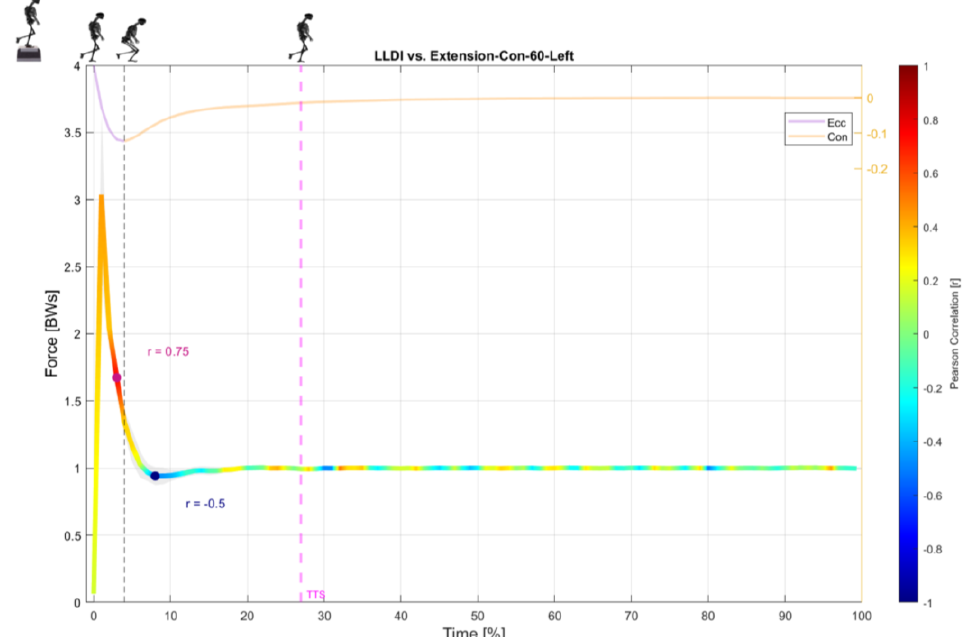
Figure 4. Representative landing force–time trace with SPM regression result for the relationship between landing force (bottom coloured line) and concentric extensor strength. Note: The force–time trace is linked to the primary y-axis, whereas each time node (x-axis) for the force trace exhibits a Pearson correlation coefficient that is colour-coded based on magnitude and direction (see colour bar). The largest positive (red) and negative (blue) coefficients are highlighted for reference. The displacement of the CoM (top line) is linked to the secondary y-axis and is colour-coded based on the eccentric (purple) and concentric (light orange) phases of landing. The vertical black dotted line represents the transition phase from eccentric to concentric landing. The vertical pink dotted line represents the time point at which stability was reached.